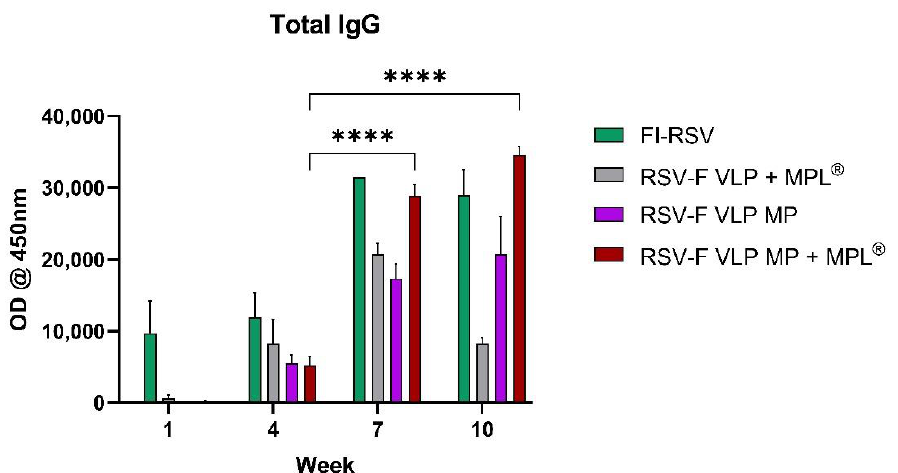
Figure 3. Total IgG measurement. RSV-F protein-specific antibody responses in mice. Mice received 1 prime and 2 booster doses of 5 µ g/dose of F VLP transdermally and 1 µ g/dose of FI-RSV (I.M.). The adjuvant group received 10 µ g of MPL ® . Serum samples collected at 1, 4, 7, and 10 weeks were analyzed for RSV-F protein-specific IgG using ELISA. Statistical significance was determined using two-way ANOVA in GraphPad Prism. Error bars represent standard error of the mean from individual animals. **** p < 0.0001.